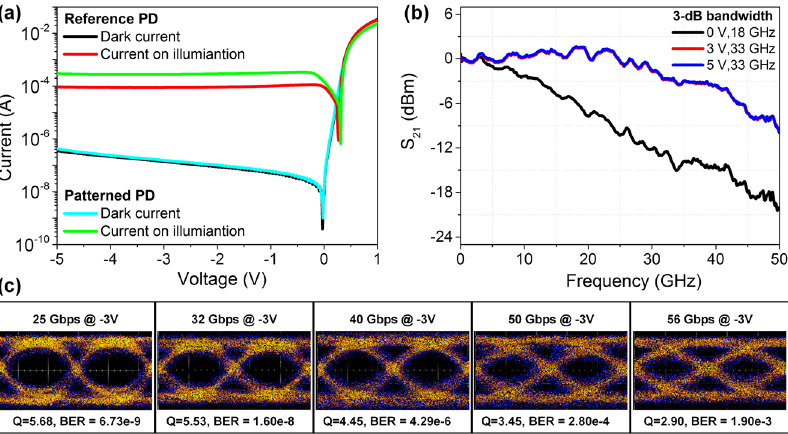
Figure 4: Electrical characterization of the 14- μ m-diameterreferencePDandpatterned PD (period: 560 nm, diameter: 320 nm). (a) I – V characteristics of the patterned